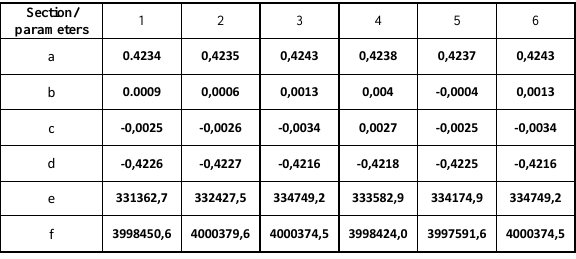
Table 1. Transformation